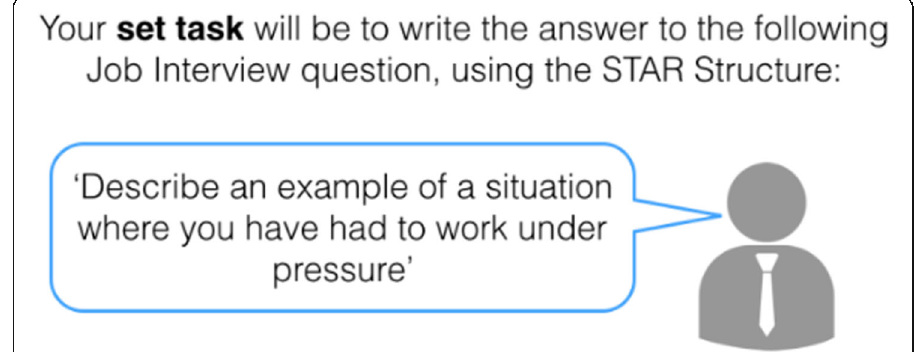
Fig. 4 The set task that participants were asked to complete in the online